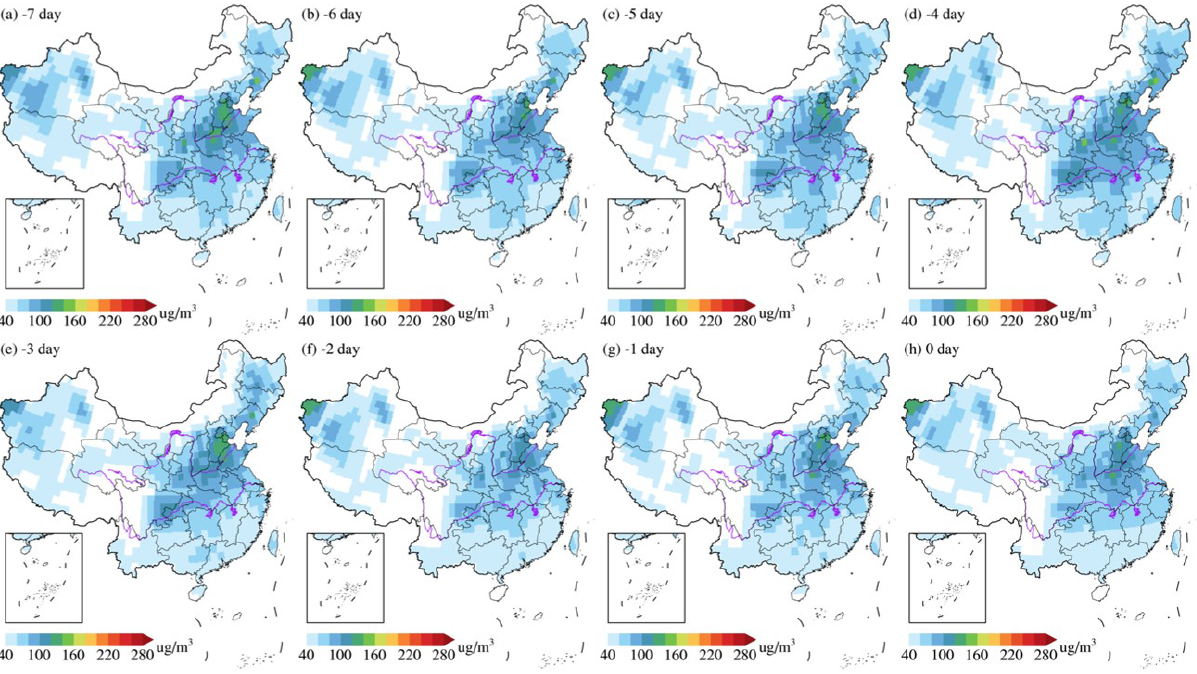
Figure 15. Composite PM 2 . 5 concentration for the six SR–noNH events in Table 2 at (a) − 7, (b) − 6, (c) − 5, (d) − 4, (e) − 3, (f) − 2, (g) − 1, and (h)